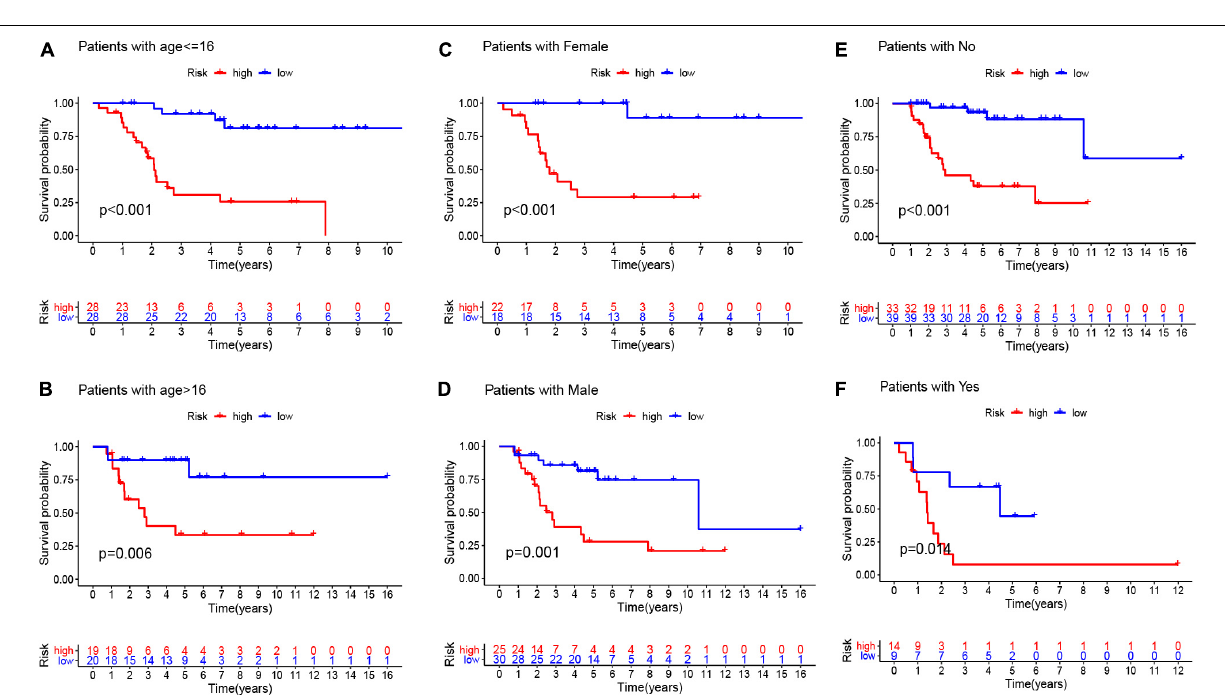
Frontiers in Cell and Developmental Biology |